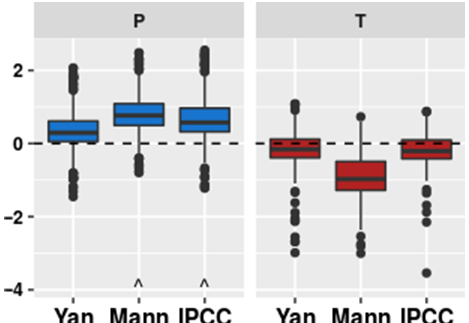
Figure 8. Difference between the means of the MCA and LIA for three definitions. Difference calculated by subtracting µ MCA from µ LIA for each ensemble member, using the three MCA and LIA definitions listed in Sect. 4. A positive value indicates LIA is more El Niño-like than MCA. Precipitation is on the left in blue, tem- perature is on the right in red. “Yan” refers to the definition used in Yan et al. (2011b), “Mann” in Mann et al. (2009), and “IPCC” in Masson-Delmotte et al. (2013). See Fig. 4 for explanation of the box plots and